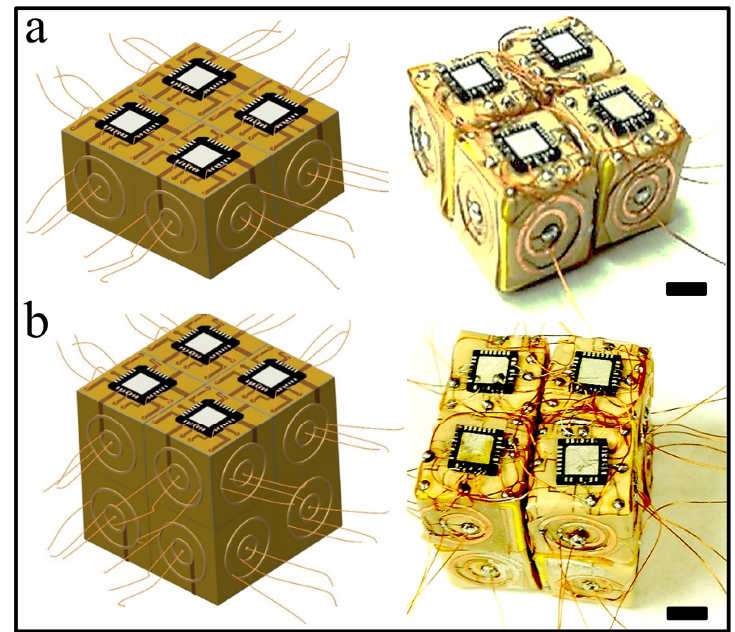
Figure 4. Fabrications of milli-E blocks. ( a ) Flexible 2D maps of circuits layers were cutout, folded, and mounted on the cube with a commercial microchip on top and interconnected Cu wires on each face using PCB (Printed Circuit Board) photolithography; ( b ) potentially mass-producible E-blocks were prepared with interconnecting wires to establish connections to the chip and circuit layers. All scales are 5 mm.